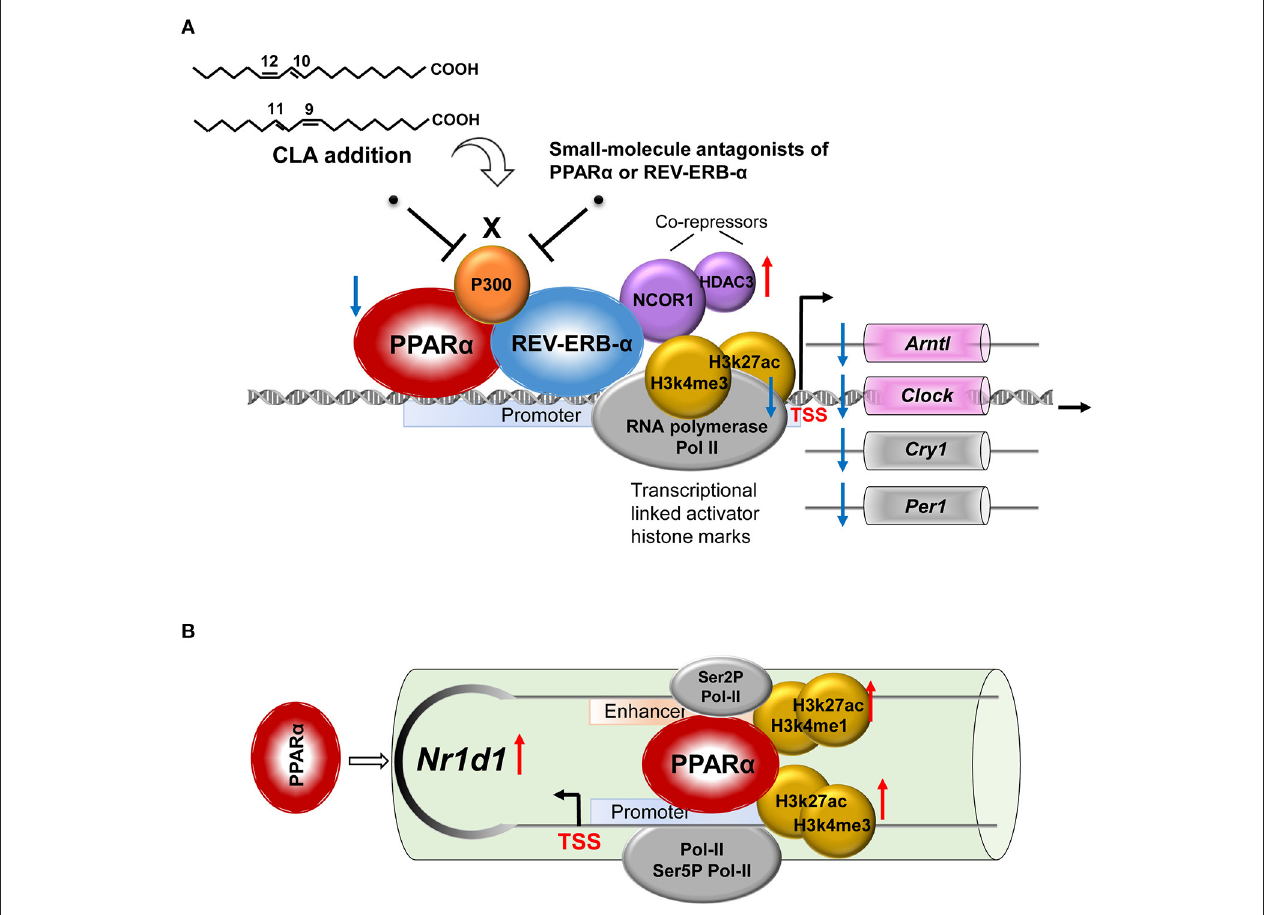
FIGURE 7 | A proposed model for the role of the NR pair, PPAR α -REV-ERB α , and its regulation of circadian clock genes in CLA-induced hepatic steatosis. (A) CLA-induced activating PPAR α and repressive REV-ERB α transcriptional complexes, the coordinate actions of which modulate the circadian clock gene expression. (B) The regulation mechanism of PPAR α in directing REV-ERB α ( Nr1d1 ) expression via the recruitment of histone marks and cofactors at both the promoter and the